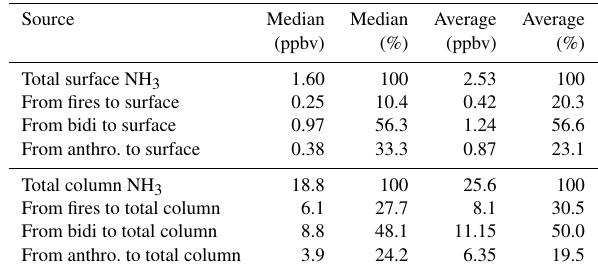
Table 3. Average source contributions to ambient NH 3 VMRs over the Alberta and Saskatchewan model domain during 12 August to